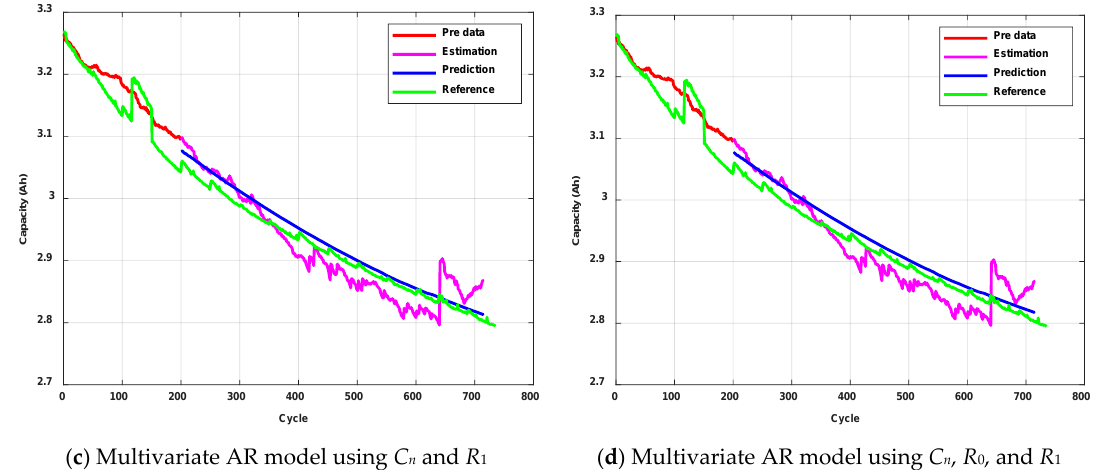
Figure 12. Capacity prediction results obtained using the AR model and dual extended Kalman filter (DEKF) (case 1). Table 3. Comparison of the mean absolute percentage error (MAPE).